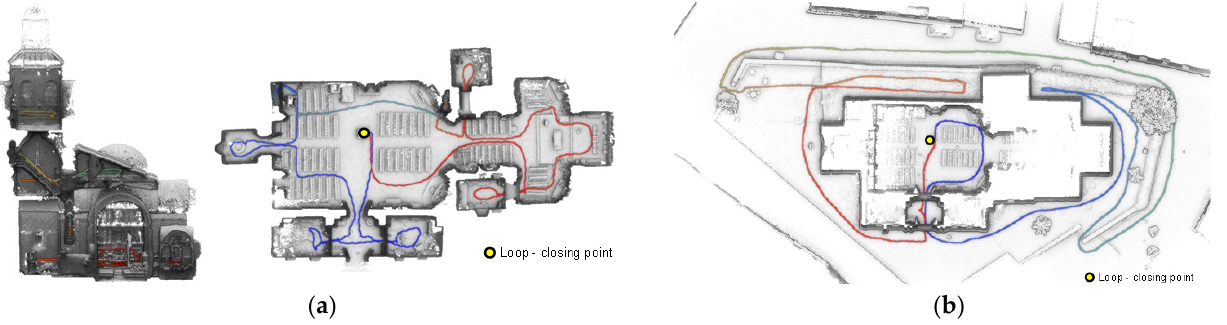
Figure 5. WMMS used during this work: ( a ) different technical components and ( b ) lifting pole system used for the 3D digitalization of upper parts.